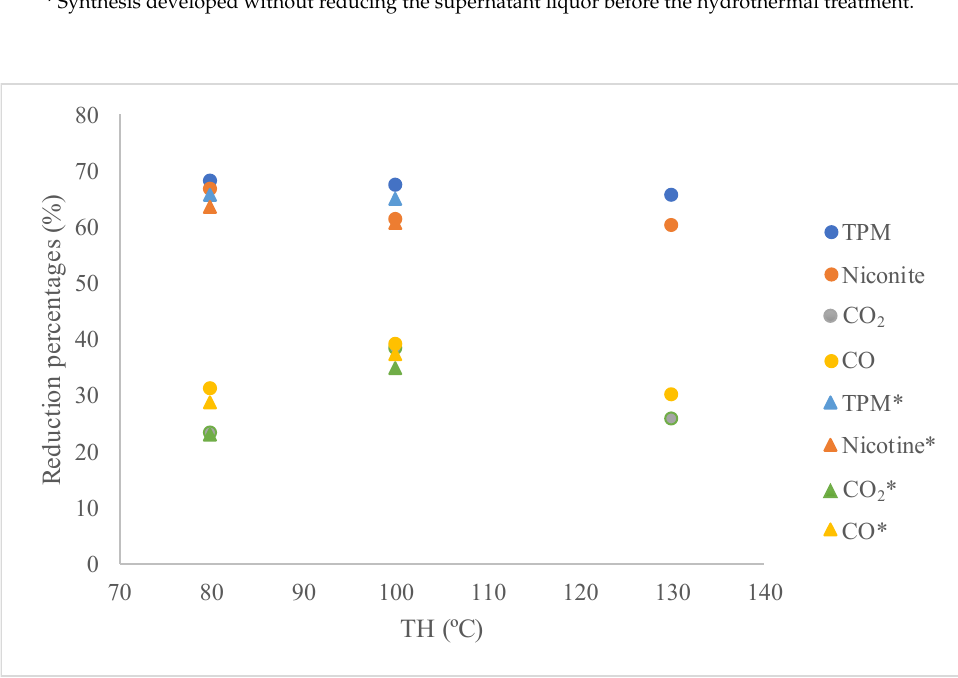
Figure 8. Reduction results of TPM, nicotine, and carbon oxides at different temperatures of hydrothermal treatment. * correspond to samples obtained after eliminating part of the supernatant liquor.